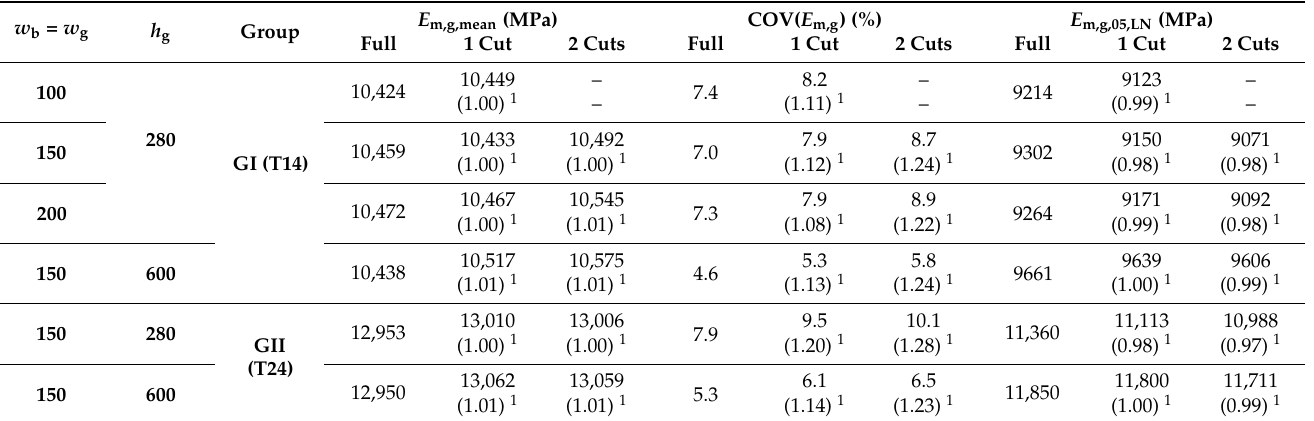
Table 13. Main statistics of the modulus of elasticity E m,g from 10 3 simulated glulam beams and resawn glulam {1 cut; 2cuts} for each parameter setting featuring various widths consequently slightly reduced 5%-quantile values are observed for decreasing separation w g = {100; 150; 200} mm, depths h g = {280; 600} mm and base material GI (T14) and GII (T24).